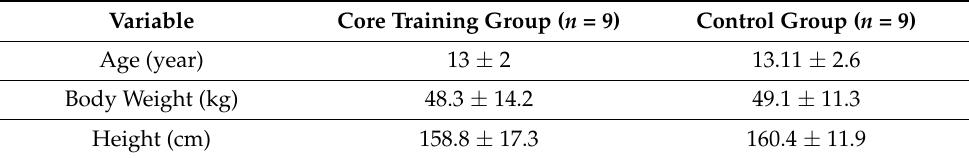
Table 2. Characteristics of the subjects. No statistically significant difference was found between the group. Values are presented as mean ± standard deviation.